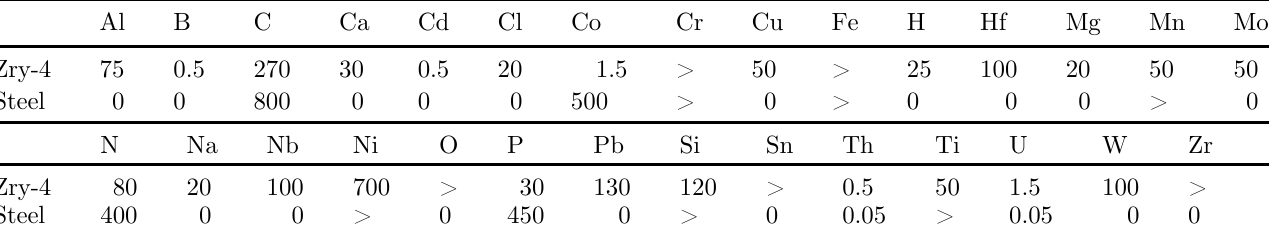
Table 2. Impurities assumed to be present ( < 1000 ppm) in the FA structural material (in ppm) for the activation calculations